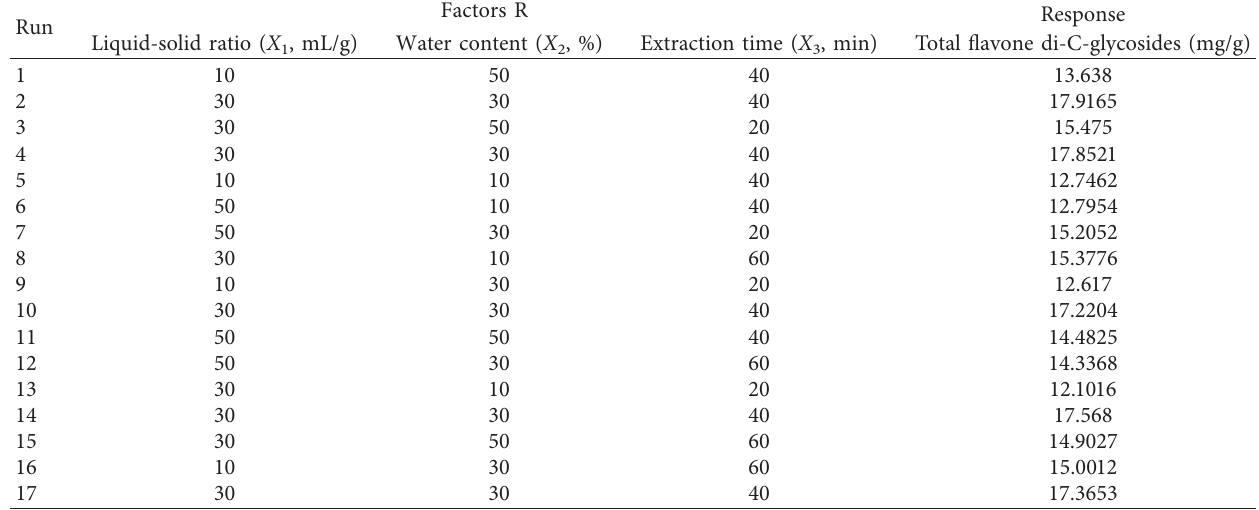
Table 3: Experimental data and obtained response values for different combinations of three factors.